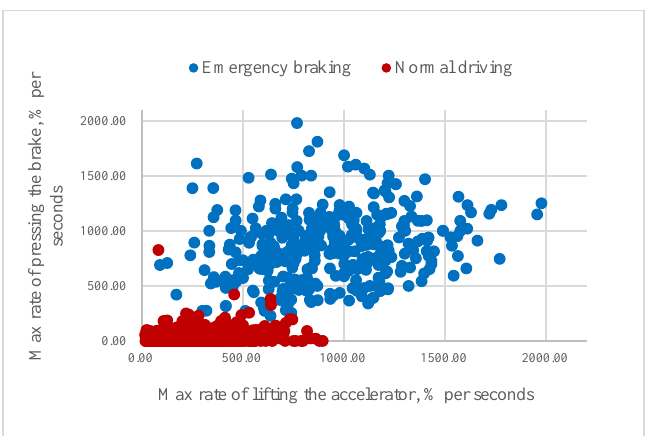
Figure 9. Relationship between the maximum rate of lifting the accelerator and maximum rate of pressing the brake pedal.